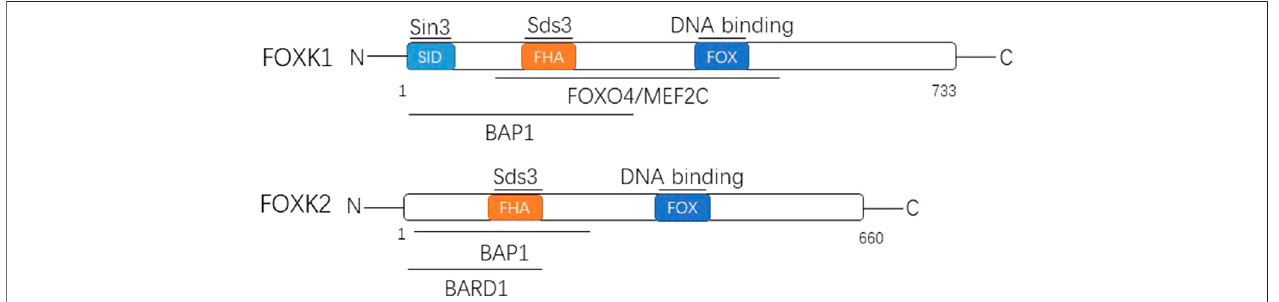
FIGURE1| ThetwomembersofFOXKfamilyareshownwiththeirdomainarrangement.Letterswithinthebarindicatestructuraldomains.Someofthewell-known proteinsinteractingwithFOXK1andFOXK2areshownabovethelinesatthecorrespondingdomains.FOX,forkheadwingedhelix-turn-helix DNAbindingdomain;FHA, forkhead-associated domain; SID, Sin3b-interacting domain; Sds3, suppressor of defective silencing 3; FOXO4/MEF2C, Forkhead Box Class O4/Myocyte Enhancer Factor-2C; BAP1, BRCA associated protein 1; BARD1, BRCA1 associated ring domain